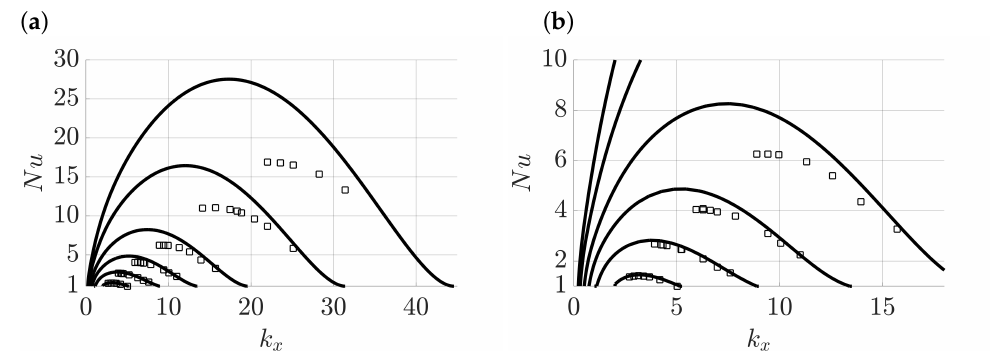
Figure 5. Nu as a function of the horizontal wavenumber k x for Ra T = 50, 100, 200, 400, 1000 and 2000 (from bottom to top) obtained from single-mode solutions (lines) and compared with DNS results (black squares) with k x = n π / L x ,NBC using n and L x ,NBC appropriate to no-flux horizontal B.C. (Figure 4 and Table 2 in [39]). Panel ( b ) is a zoom of panel ( a ).